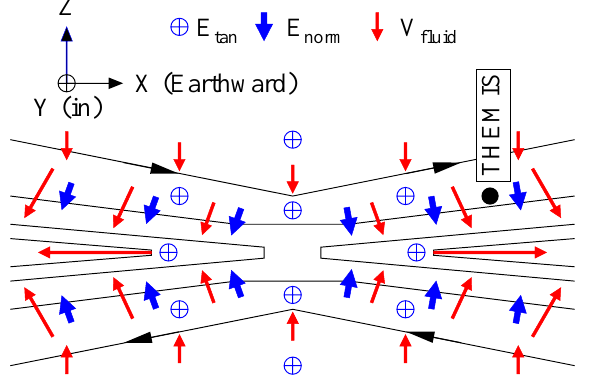
Fig. 3. Schematic based on Wygant et al. (2005) showing the region tailward of − 10 R E . Electric fields are indicated in blue, plasma flows in red, and magnetic fields in black. The rough position of the THEMIS spacecraft is indicated. In keeping with the original dia- gram, only the in-plane fluid velocity is shown. It may be inferred from E × B that V has a significant out-of-page component.